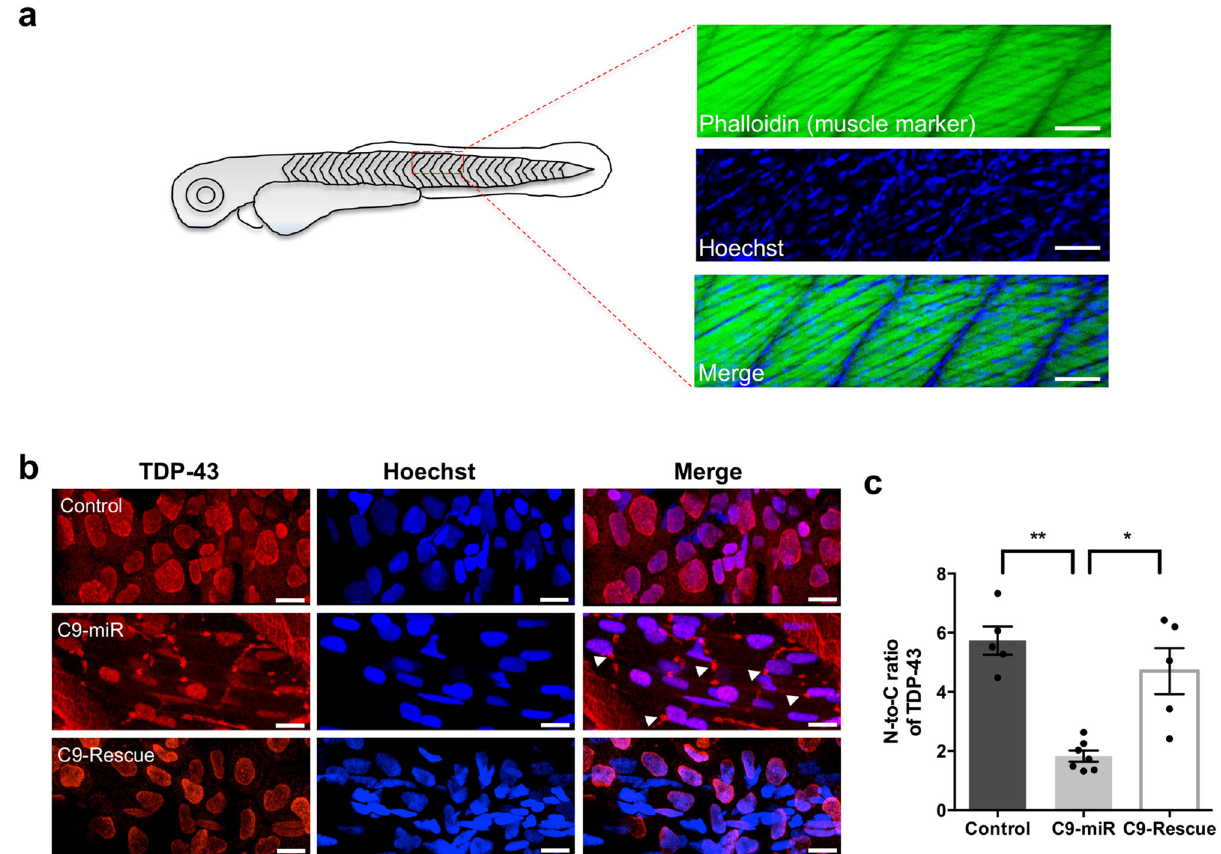
Fig. 4 C9-miR zebra fi sh displayed TDP-43 pathology. a Illustration of 6 dpf zebra fi sh skeletal muscle cells with large nuclei labelled with muscle marker, phalloidin, and nucleus marker, Hoechst. b Representative images of 6 dpf zebra fi sh skeletal muscle cells for TDP-43. Compared to control fi sh, we observed cytoplasmic clustering of TDP-43 expression in the C9-miR skeletal muscles that can be rescued in C9-rescue fi sh. Arrows indicate clusters of TDP-43 expression. c Quanti fi cation of the nucleus-to-cytoplasmic ratio for TDP-43. A signi fi cant reduction in N-to-C for TDP-43 was observed in C9-miR zebra fi sh ( n = 7; ** p < 0.005; one-way ANOVA) that can be signi fi cantly rescued upon the expression of the human C9orf72 mRNA ( n = 5; * p < 0.05; one- way ANOVA). Scale bar = 50 μ m. Data are presented as mean ± SEM. n represents the number of fi